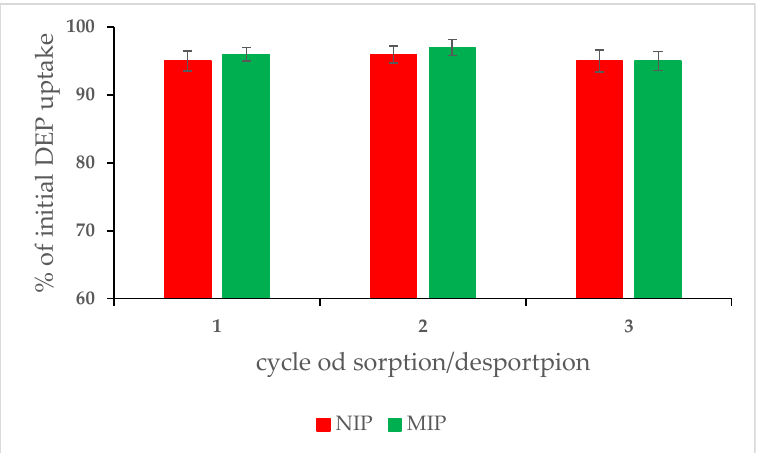
Figure 4. Sorption cycles of MIM and NIM in three cycles of sorption and desorption. The data collected show that changes of conditions and acting during cycles of sorption and desorption did not deteriorate the sorption properties of the investigated sample. The sorption capacity for both MIM and NIM was almost the same as for fresh membranes (95–97%). During desorption, all sorbed DEP was desorbed. This phenomenon was also observed during another study in our research team, with the core-shell materials type [50].